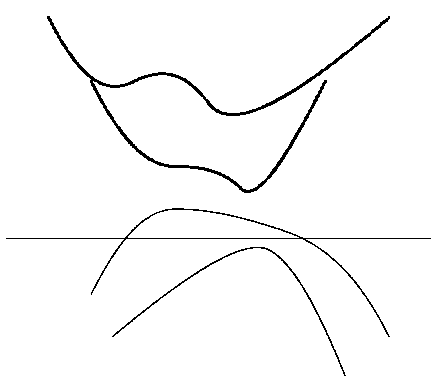
Figure 9 . Fate of (cid:12)gure 8 after switching on Im ( p 1 ). Di(cid:11)erent singular loci associated with di(cid:11)erent a propagators undergo di(cid:11)erent amounts of vertical shift. In this (cid:12)gure it is no longer possible to choose the k 1 integration contour along the real axis, but it is possible to (cid:12)nd a deformed contour s from (cid:0)1 to 1 that avoids the singularities.